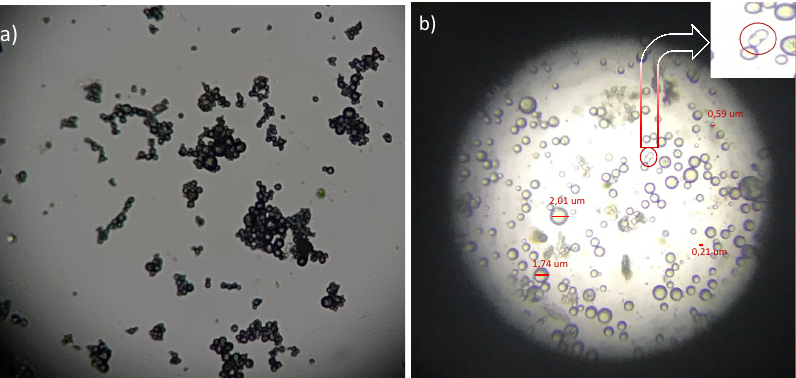
Figure 2. PVA emulsion from thyme essential oil under optical microscope. ( a ) 500 rpm; ( b ) 1000 rpm.